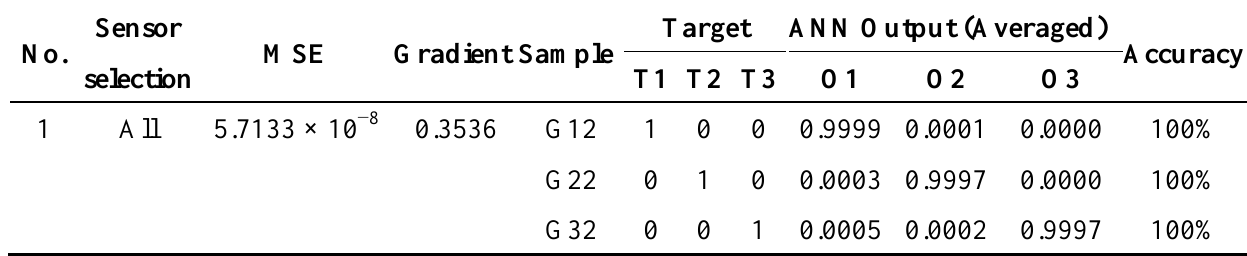
Table 3. ANN output for 32